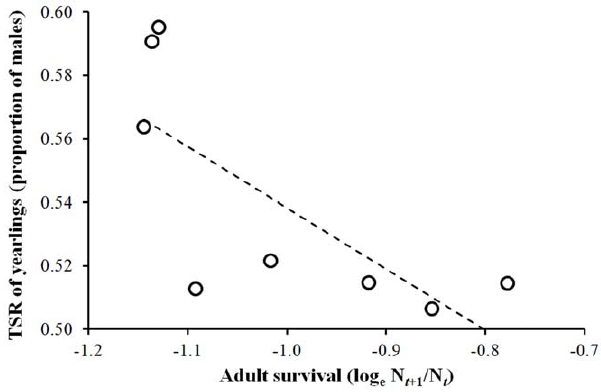
Figure 1. TSR of yearlings in the population in any ( t + 1)-th study year in relation to adult survival between year t and year t + 1. The analysis was restricted to the years when more than 180 yearlings were sampled (see Statistical analyses